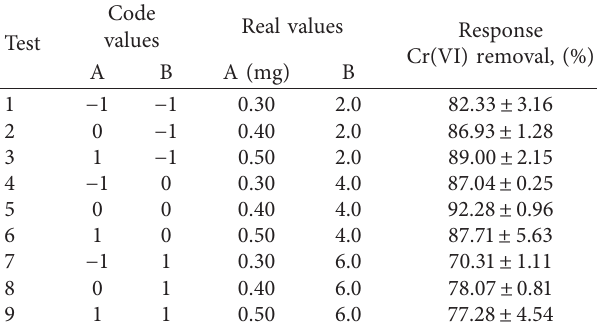
Table 2: Factorial design for the independent variables used in this study along with the observed response.